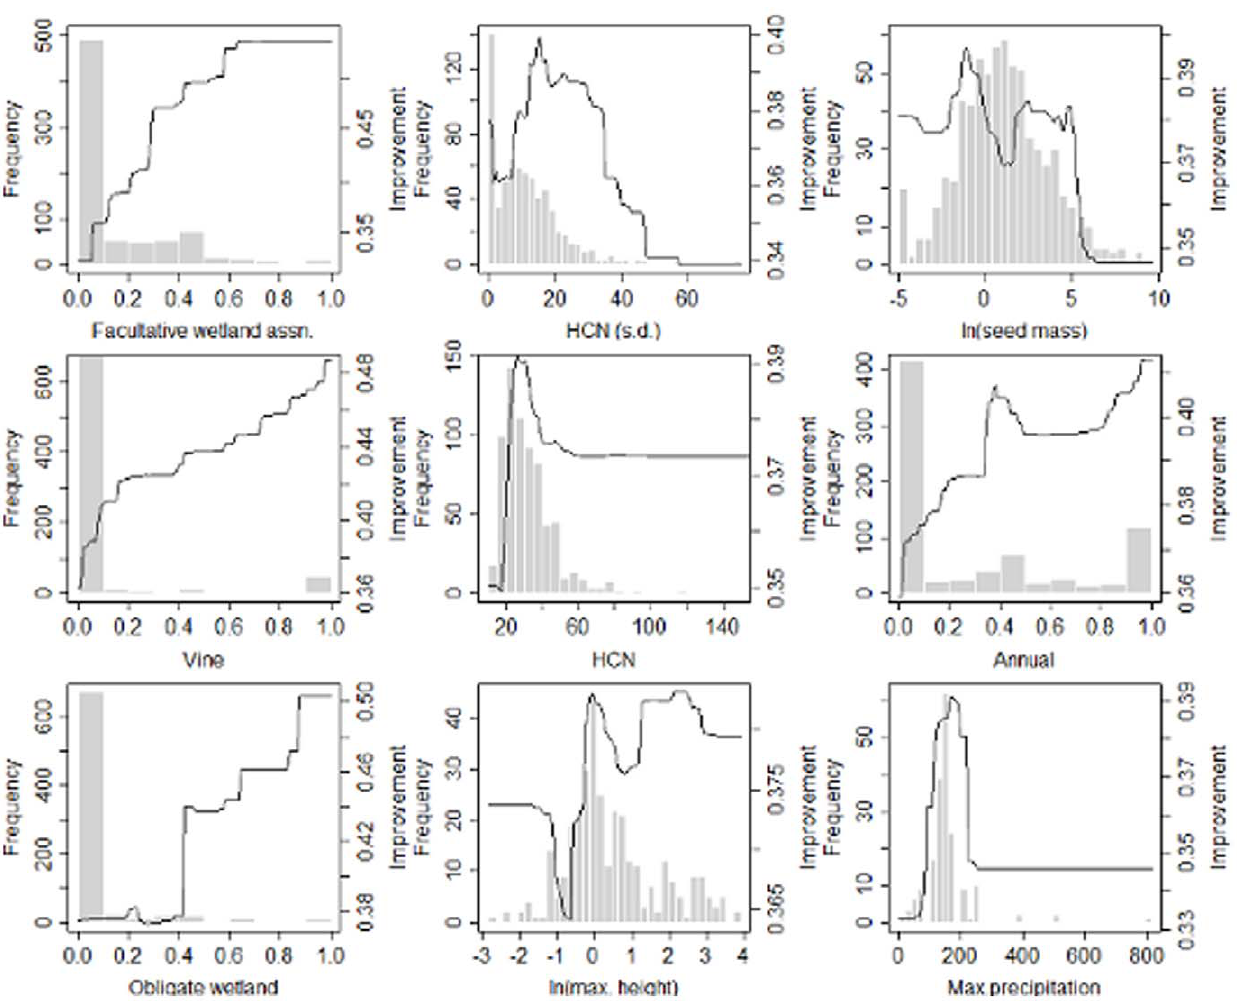
Figure 2. Marginal plots (improvements of the GBM model predicting noxious proportion as a function of a single explanatory variable [ 43 ] ) overlaid on a frequency histogram (summarizing over the entire dataset of 760 genera) of each explanatory variable. Right hand y-axis is the log-odds ratio for final GBM models (using training + validation data sets to train the model). Graphs are arranged by order of explanatory variable importance. HCN= highest chromosome number mean, and HCN (s.d.) = standard deviation in highest chromosome number by genus.